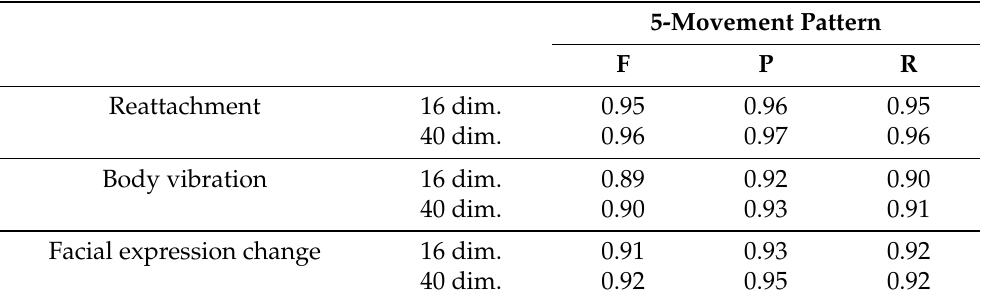
Figure 10. Results for gaze movement pattern in Evaluation 3. The value is the F-value. Table 5. Result of each condition for each pattern in Evaluation 3. (R: Recall, P: Precision, F: